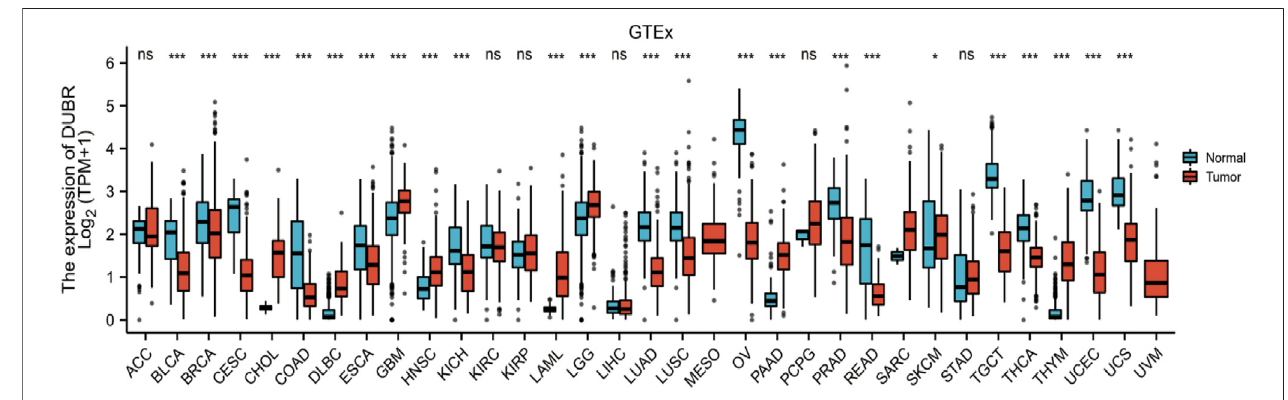
FIGURE 1 | DUBR levels within diverse cancers. DUBR levels within 33 different human cancers were measured according to The Cancer Genome Atlas (TCGA) cancer and normal data. Tumor tissues and matched normal TCGA and GTEx tissues were compared. * p < 0.05; ** p < 0.01; *** p <